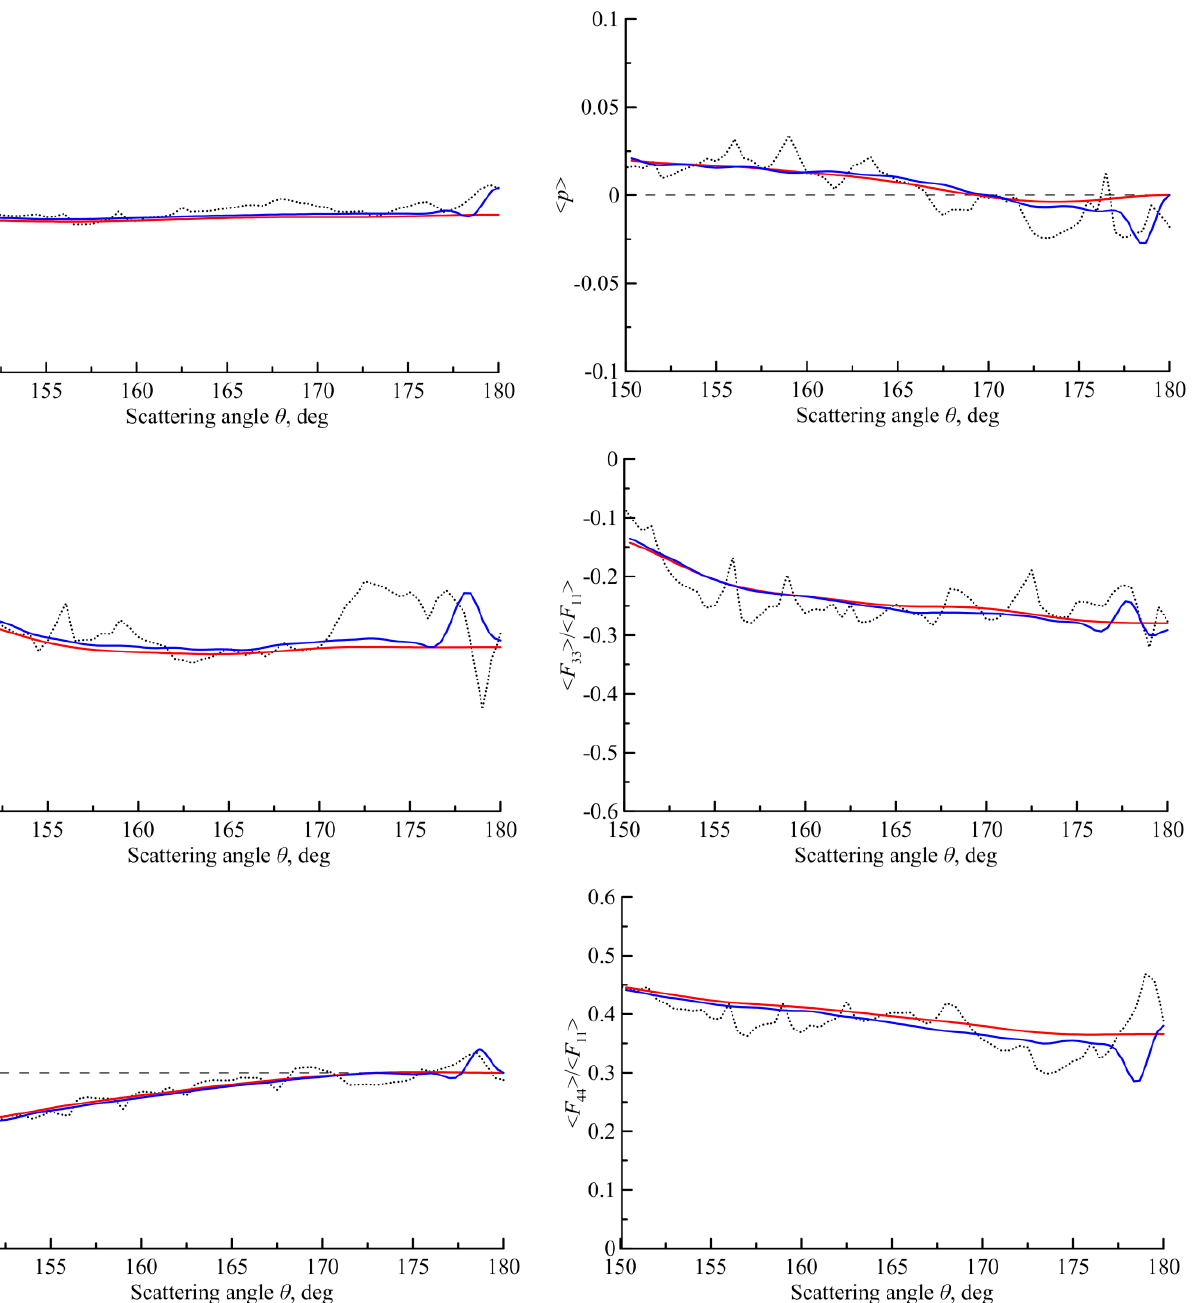
Figure 2. The scattering matrix for the shape 1 of Figure 1.